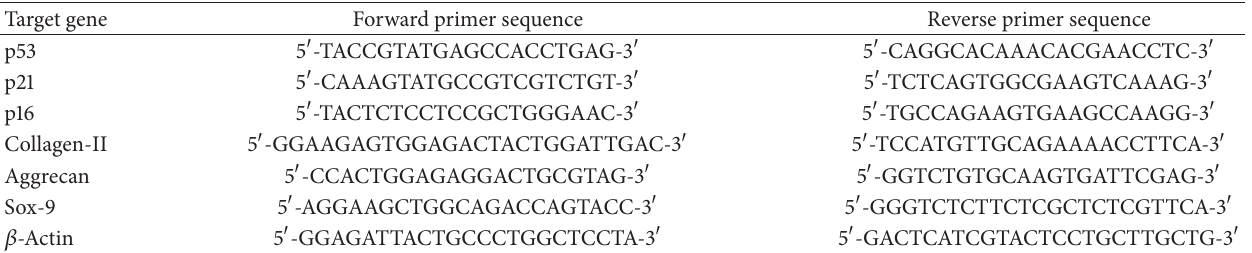
Table 1: Primers utilized for real-time PCR